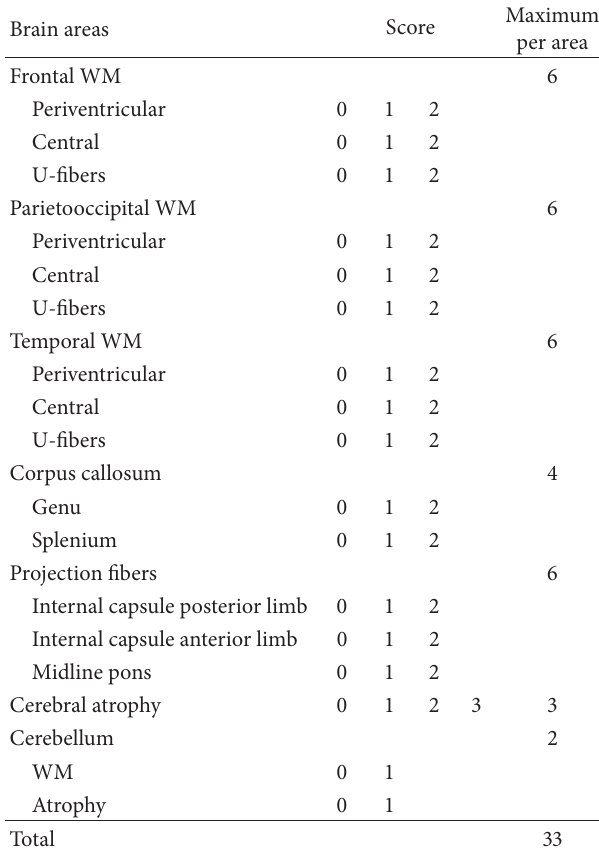
Table 1: Brain imaging scoring system